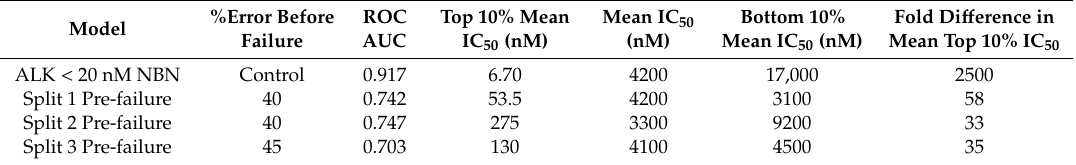
Table 4. Performance statistics for NBNs with retained predictivity generated with the specified error in each split.